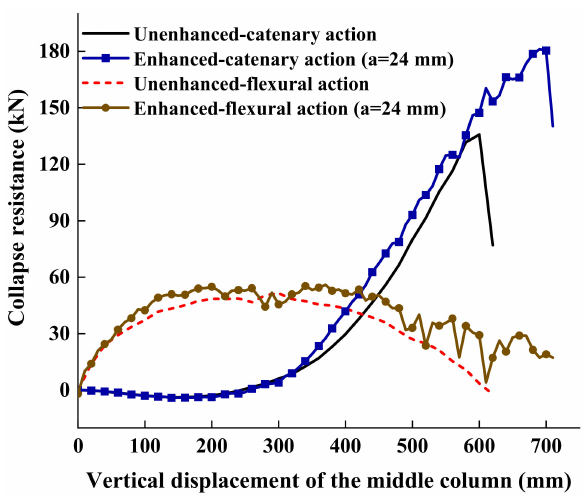
Figure 21. Collapse resistance mechanisms of model M0-RS2-a24.